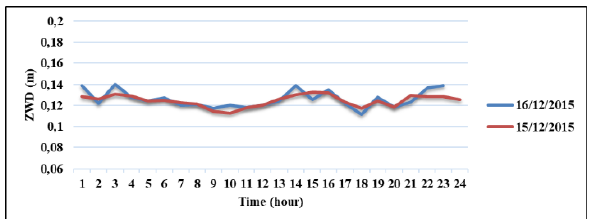
Figure 11. PM 10 time series of Zonguldak. A difference of 2 μg/m 3 was observed at the average PM 10 value between 06-07 November 2015, whereas an average difference of 4 mm was calculated for the wet zenith delay values. Figure 12 shows ZWD values on 06-07 November 2015.